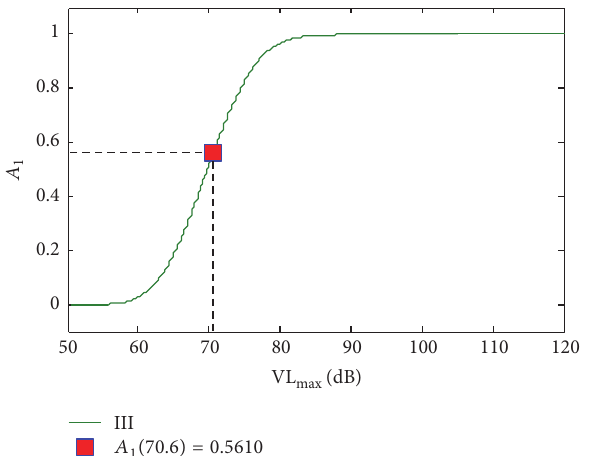
Figure 7: Annoyance degree of structural vibration at measurement point E0.